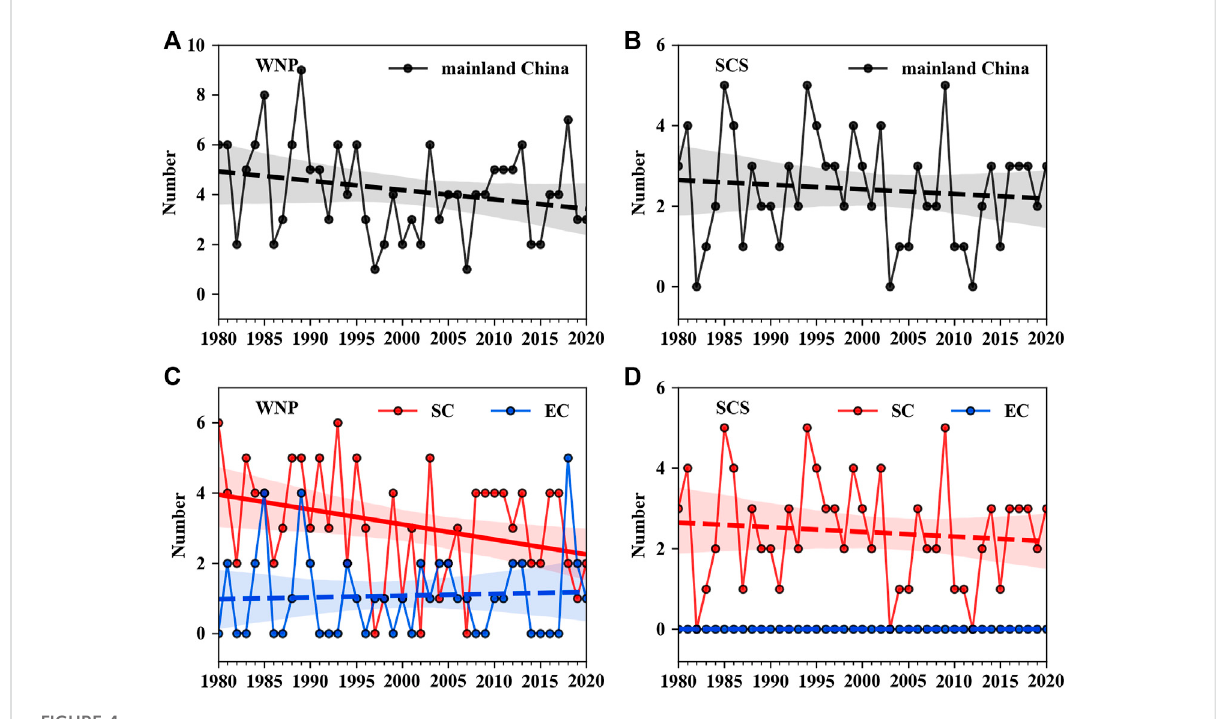
FIGURE 4 The same as Figure 2, but for theannual number of theTCs generated in the WNP (A,C) and SCS (B,D) and made landfall inmainland China, SC, and